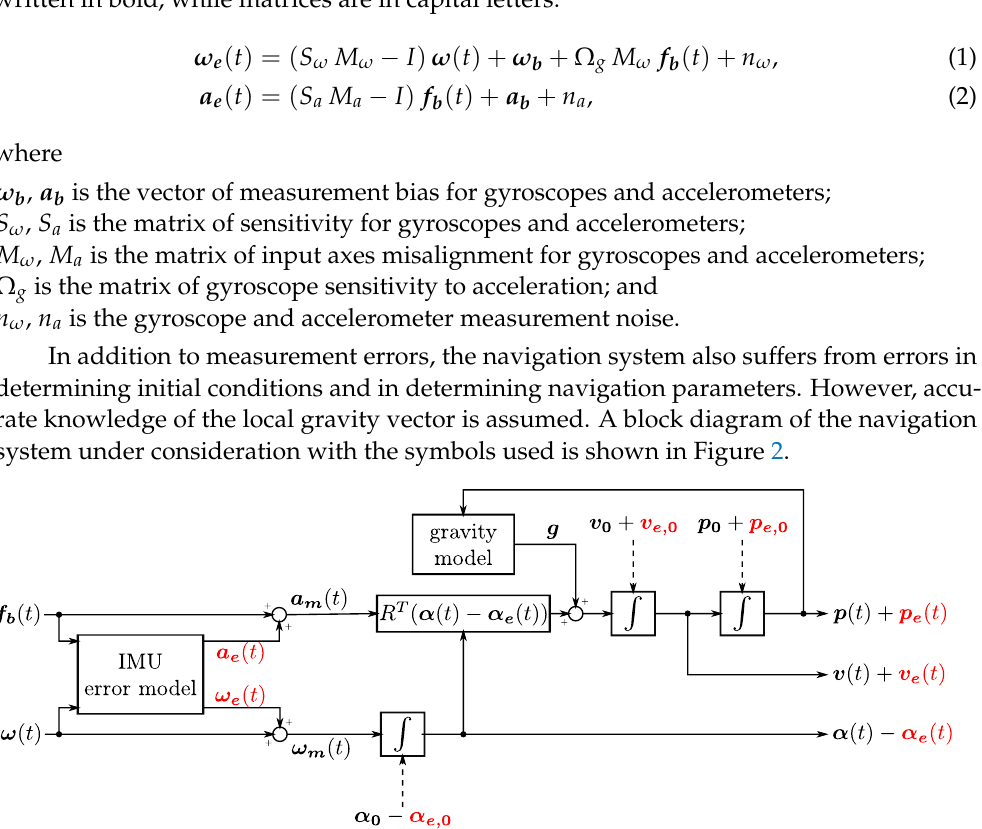
Figure 2. Block diagram of basic strapdown INS signals propagation for accuracy